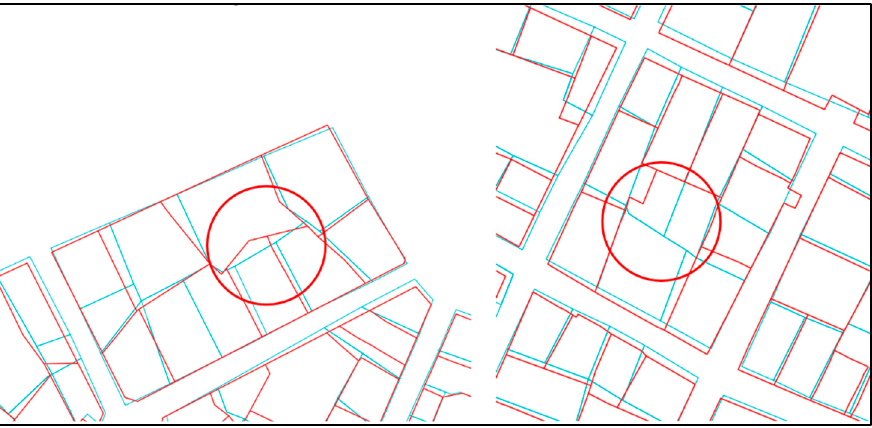
Figure 25. Obvious errors in land parcel boundaries identification-edited land parcels (light blue), official cadastral land parcels (red).